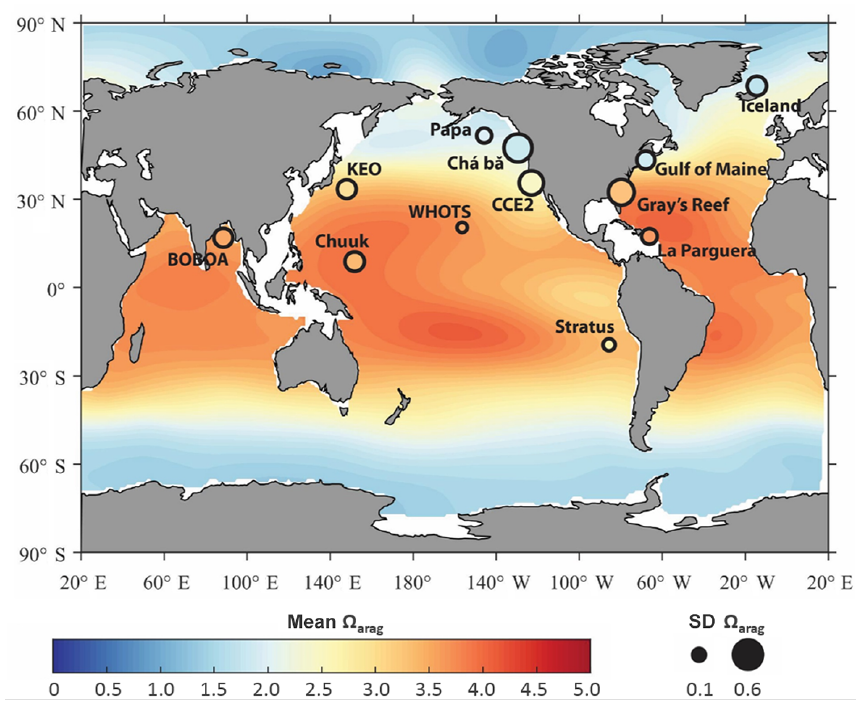
Figure 1. Locations of moored p (CO 2 ) and pH observations. Base map is adapted from Jiang et al. (2015) and shows annual climatological distribution of surface (cid:127) arag throughout the global oceans. Added to this base map are moorings from this study where symbol color denotes annual mean (cid:127) arag (values also listed in Table 4), and the size of symbols represents (cid:127) arag variability as measured by 1 standard deviation (SD) of the annual